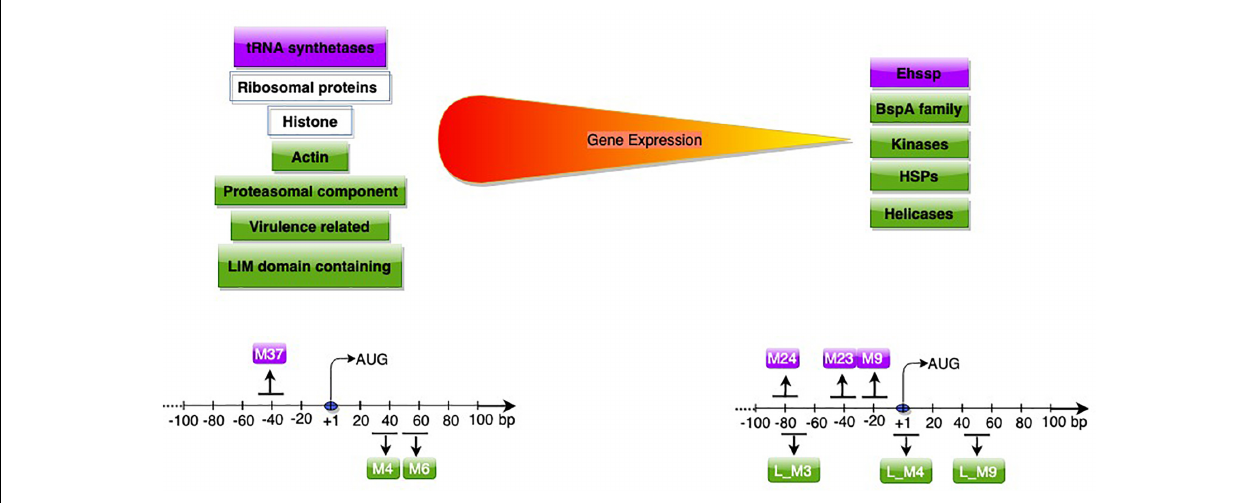
FIGURE 3 | Genes (upper panel) and promoter motifs (M) (lower panel) associated with high/low gene expression. Genes and motifs in purple (Hackney et al., 2007) in green (Naiyer et al., 2019), in white (both studies). The peak position of each motif with respect to AUG is shown; for further details of dispersed motifs please refer to Naiyer et al.